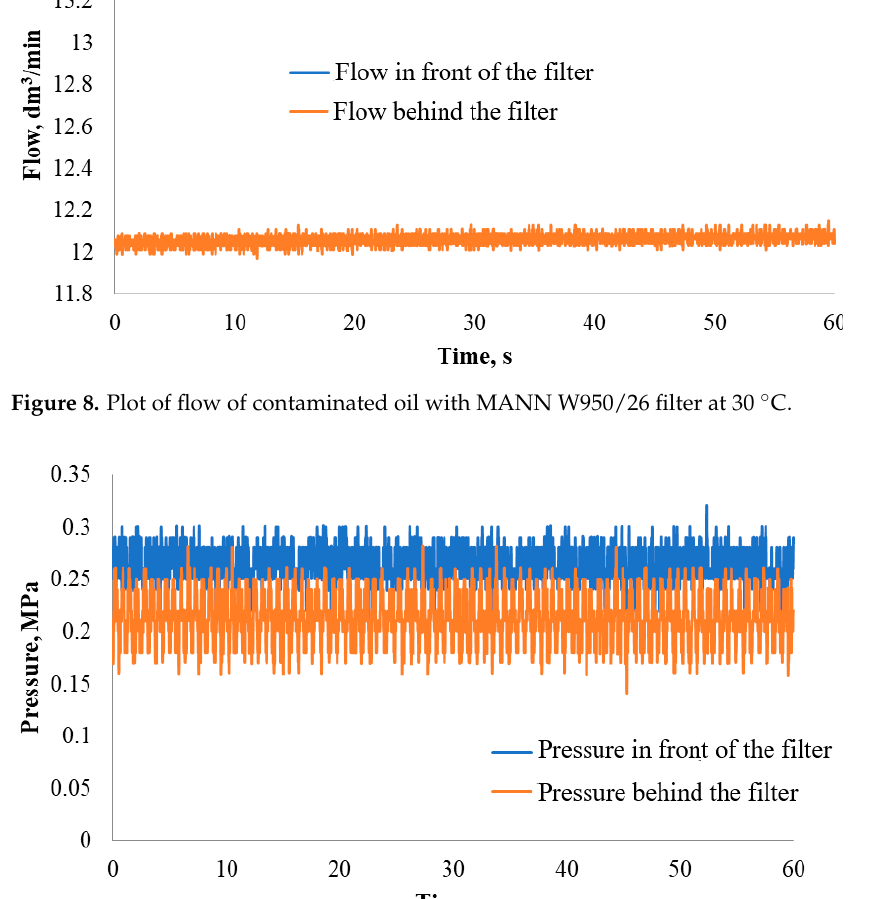
Figure 9. Plot of pressure of contaminated oil with CNH Industrial 2992242 filter at 30 °C.